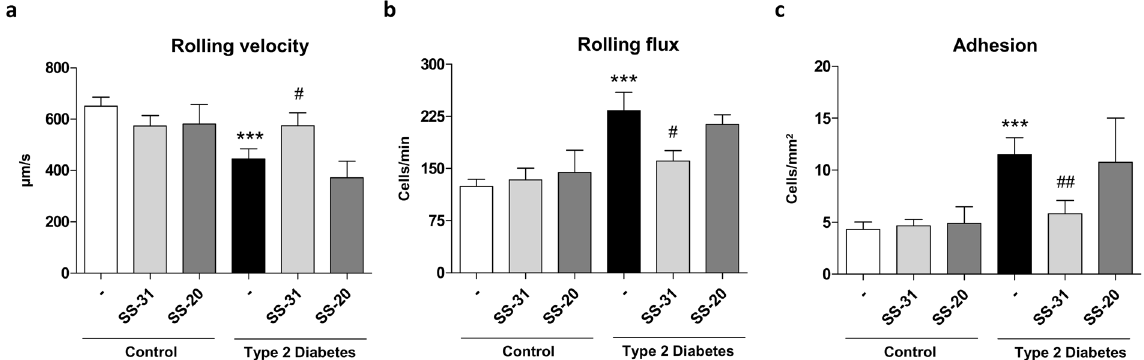
Figure 3. Evaluation of cell interactions in the absence and presence of SS-31 (30 min, 100 nM) in leukocytes from T2D patients and control subjects ( a ) Rolling velocity ( μ msecond − 1 ) ( b ) Rolling flux (leukocytes per minute) and ( c ) Adhesion (leukocytes per square millimetre). *** p < 0.001 with regard to control group # p < 0.05 ## p < 0.01 vs . non-treated T2D group.